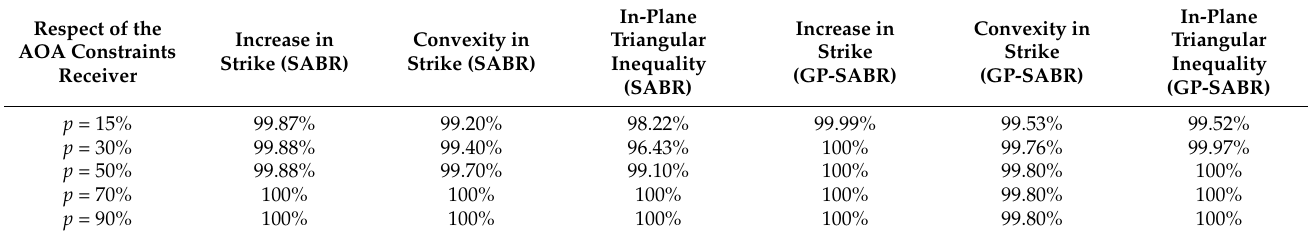
Table 10. Respect of the no-arbitrage constraints for the predicted OTM receiver swaptions priced by the SABR model calibrated on observations or on the output of the GP model, for increasing sizes of training